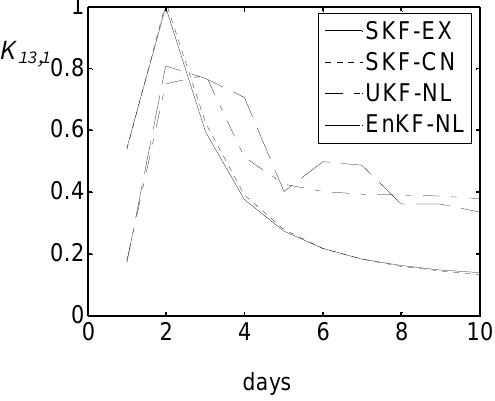
Figure 2. Evolution of the K 13 , 1 during the assimilation process with different assimilation algorithms. 4